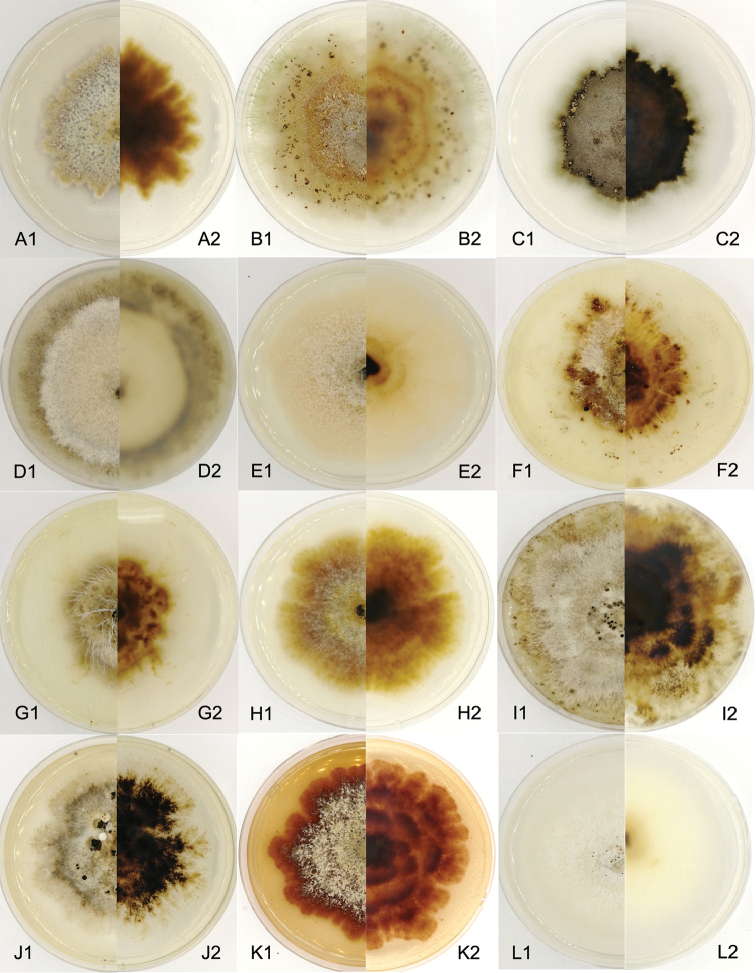
Dendrostoma cultures on PDA after 1 month at 25 °C, AD.auroraeBD.castaneaeCD. castaneicolaDD.chinenseED.dispersumF–GD.osmanthiHD.parasiticumID.qinlingenseJD.quercus; KD.shaanxienseLD.shandongense.